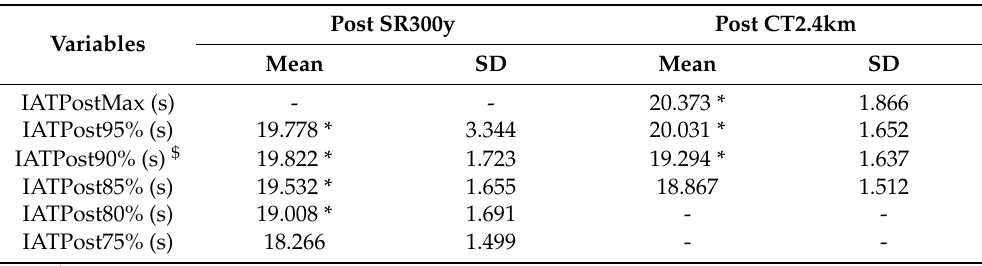
Table 2. Descriptive characteristics, repeated measure ANOVA, and paired sample t -tests for the Illinois Agility